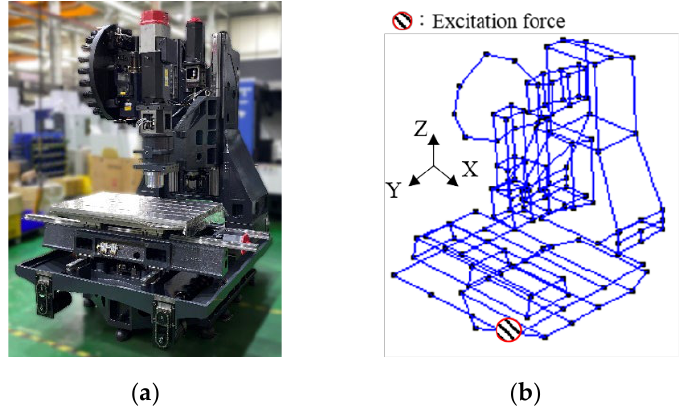
Figure 9. Vertical machining center: ( a ) experimental model; ( b ) EMA model. Table 1. Equipment parameters for impact testing.